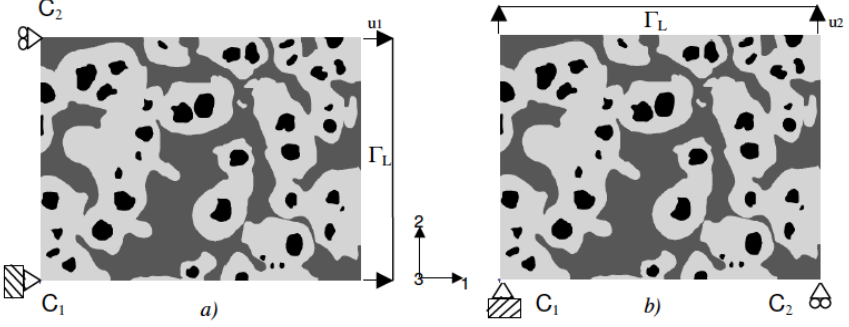
Figura 12: Modello windowing della ghisa nodulare.